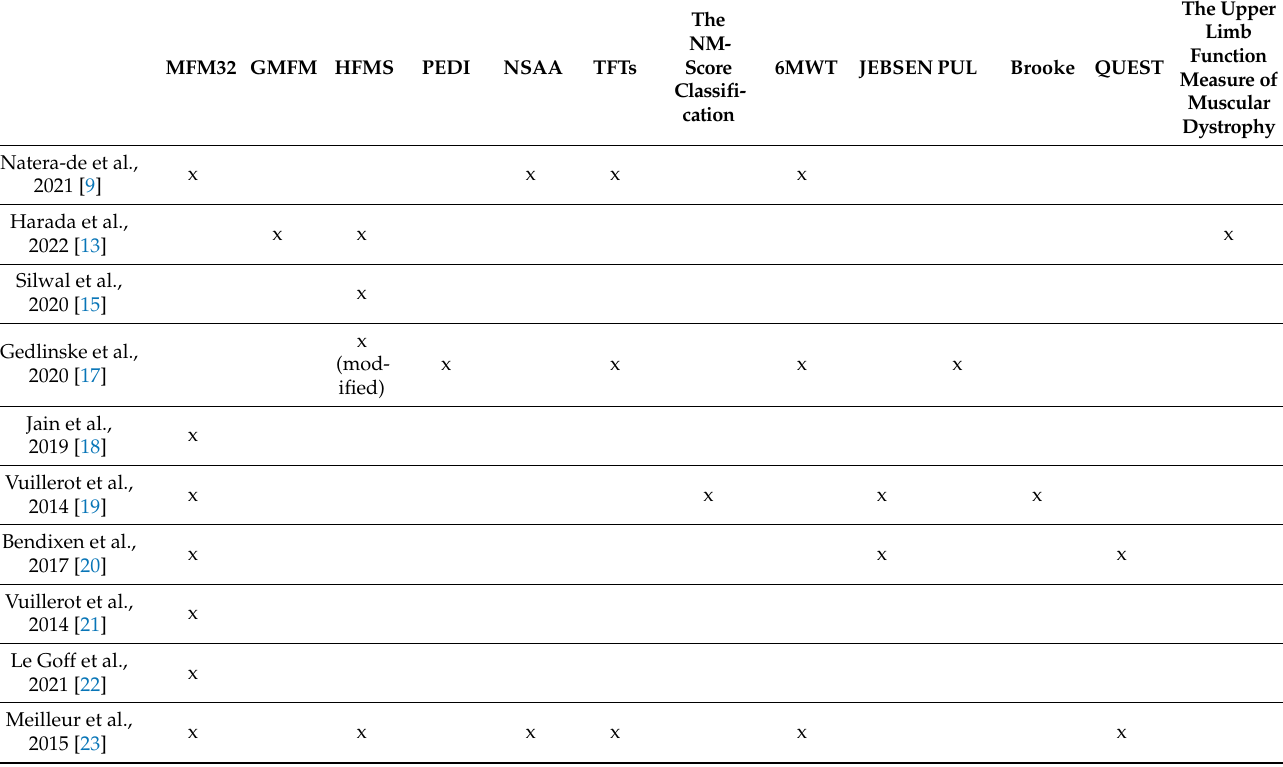
Table 8. Assessment tools used in the various selected studies (MFM32: Motor Function Measure; GMFM: Gross Motor Function Measure; HMFS: Hammersmith Motor Function; MHFMS: Modified Hammersmith Motor Function; PEDI: Pediatric Evaluation of Disability Inventory; NSAA: North Star Ambulatory Assessment; TFTs: timed function tests; 6MWT: 6 min walk test; Jebsen: Jebsen–Taylor Hand Function Test; PUL: Performance of Upper Limb; Brooke scale; QUEST: Quality of Upper Extremity Skills